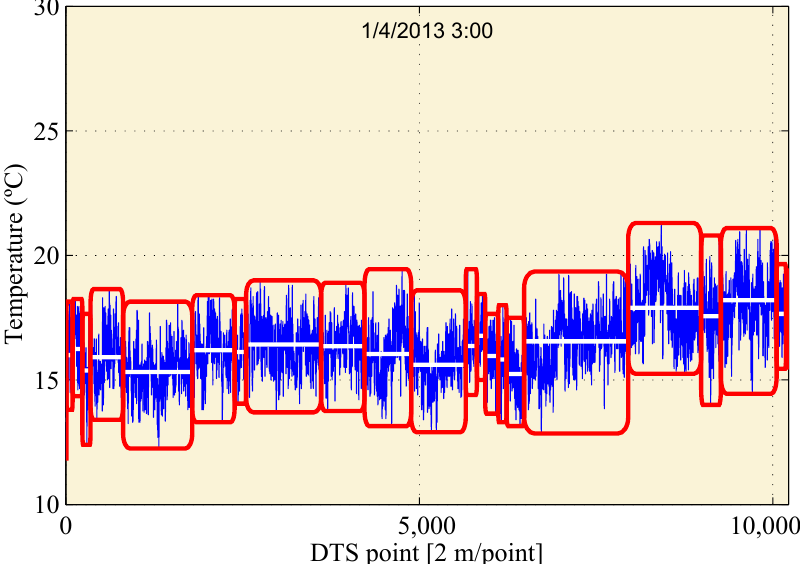
Figure 10. Evolution of conductor temperature along the line in a specific